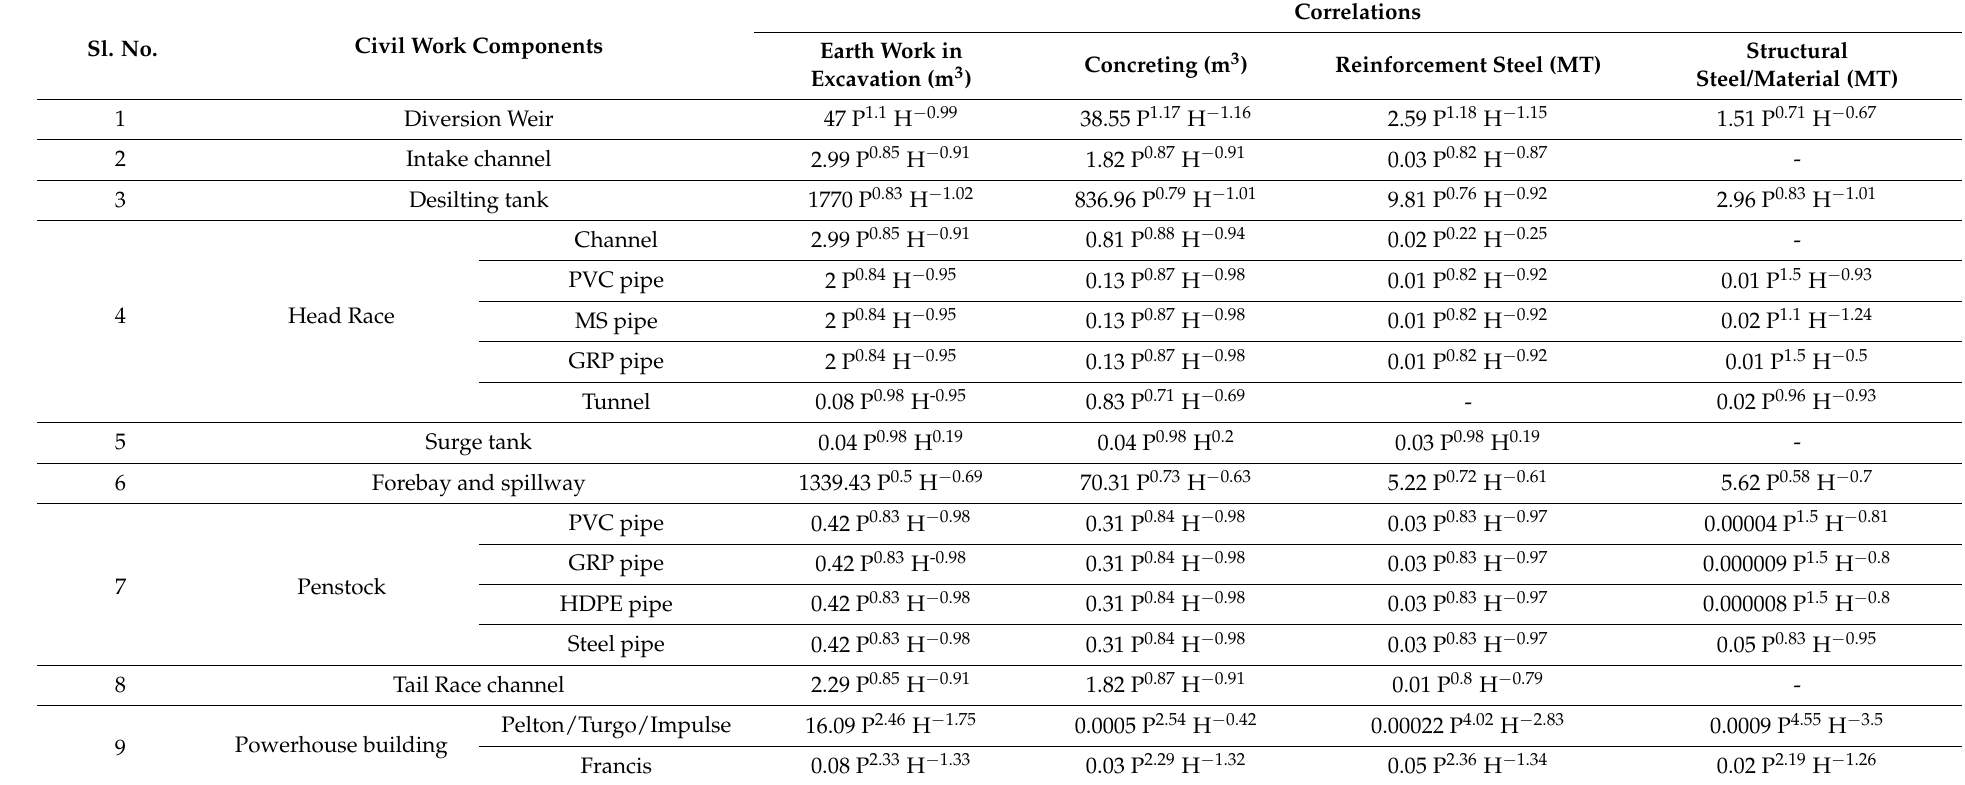
Table 3. Correlations for cost components of high head SHP plants